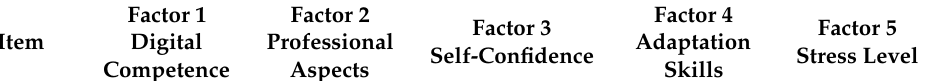
Table 3. Exploratory Factor Analysis of the survey.